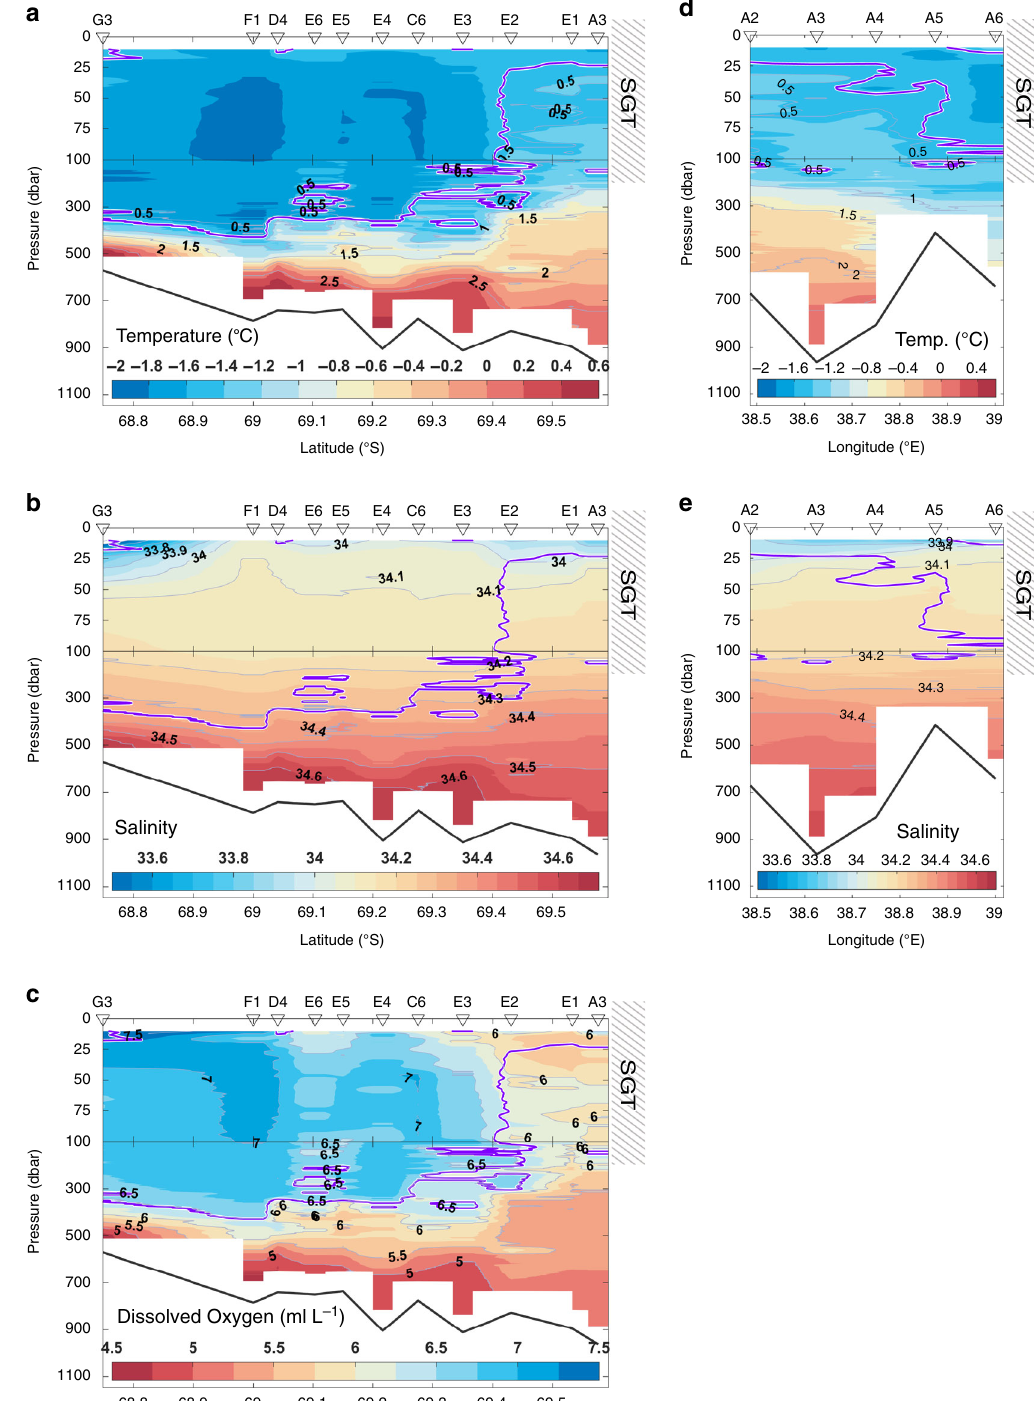
Fig. 2 Warm water in fl ow/meltwater out fl ow into/from SGT cavity. Along-trough vertical sections of ( a ) temperature ( o C), ( b ) salinity, and ( c ) dissolved oxygen (ml L − 1 ). Across-trough vertical sections at SGT ice front stations (Sta.A2-A6) of ( d ) temperature ( o C) and ( e ) salinity. On panels a and d , color shading (with color scale) and contours (with contour labels) represent temperature and temperature anomaly from in-situ freezing point, respectively. Contours of T = − 1.5 o C are shown by thick purple lines (WW layer is de fi ned as T < − 1.5 o C) 19 . Hatched boxes represent the approximate ice draft ~200 m at the northern part of the SGT. Note that vertical scales above and below 100 dbar are